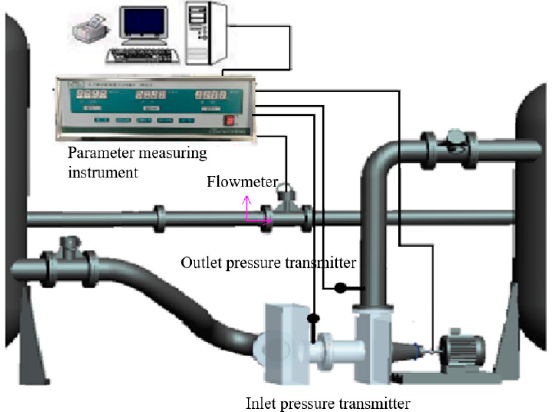
Figure 7. Schematic diagram of intelligent test system for pump parameters.